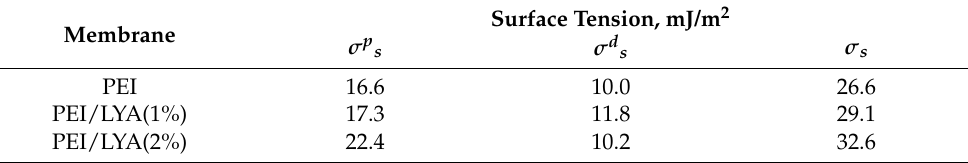
Table 4. Data on surface tension, 20 ° С .